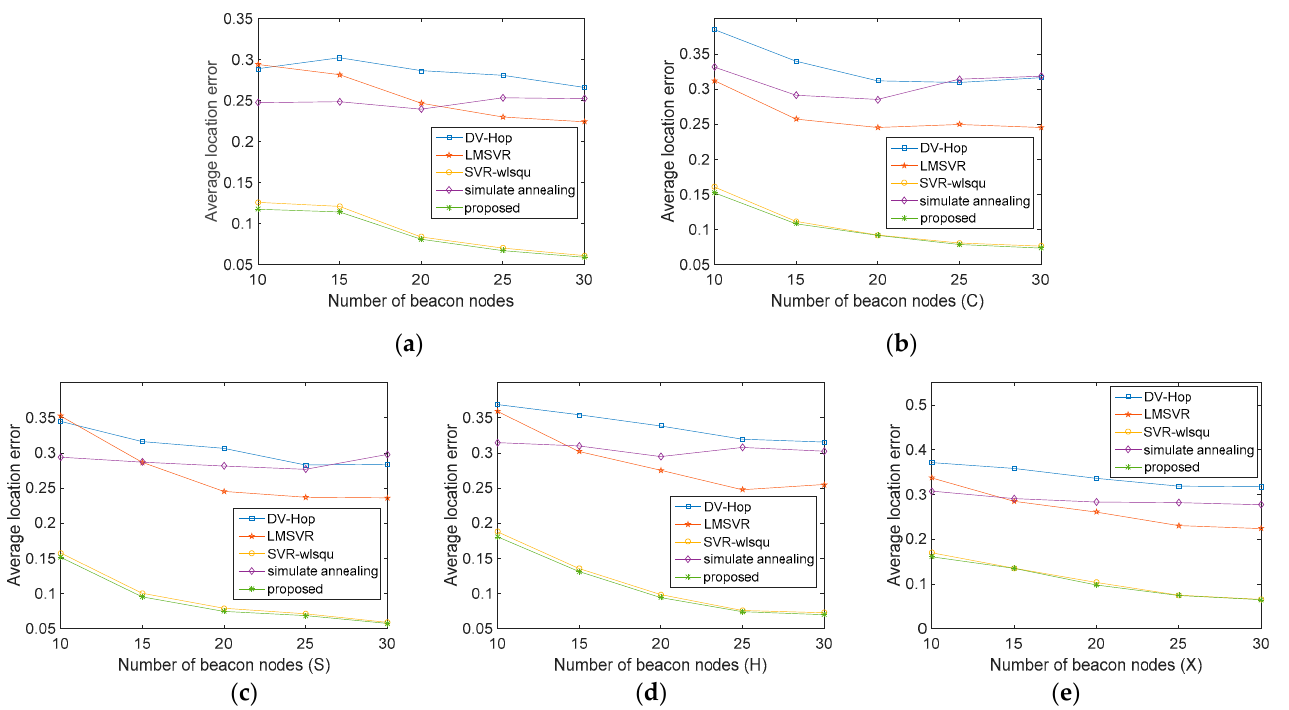
Figure 4. Comparison of the average location error under various numbers of beacon nodes. ( a ) isotropic networks. ( b ) C-shape network. ( c ) S-shape network. ( d ) H-shape network. ( e ) X-shape network.